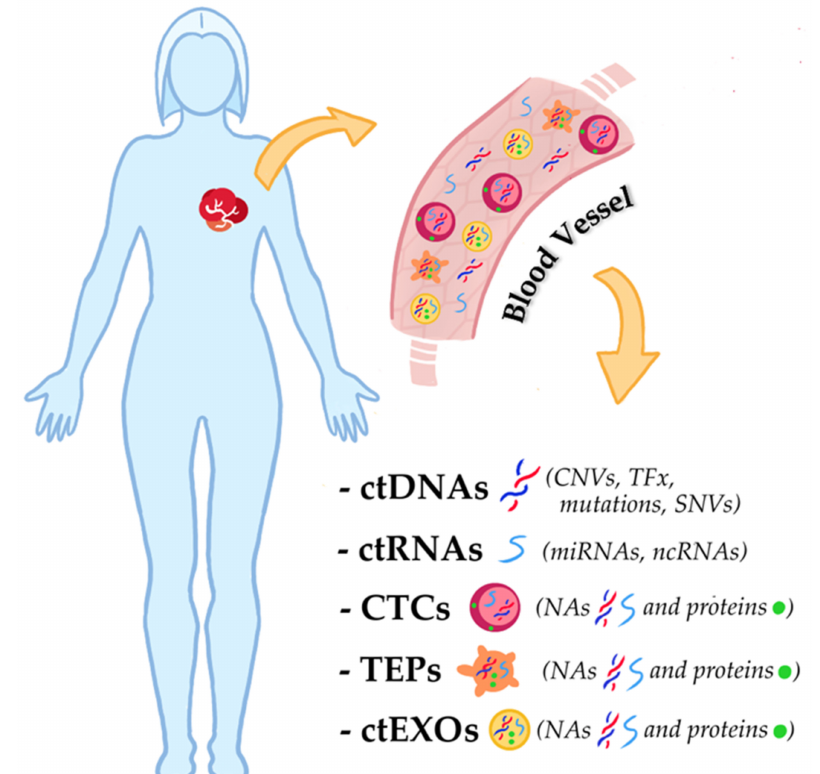
Figure 1. Scheme of principal targets from liquid biopsy in TNBC research. As shown in the figure, the biomolecular analysis from body fluids, such as blood, is not limited to circulating cell-free nucleic acids but also considers the tumor biomolecules carried by CTCs, TEPs, and ctEXOs. Abbreviations: CNVs (copy number variations); CTCs (circulating tumor cells); ctDNAs (circulating cell-free tumor DNAs); ctEXOs (circulating tumor exosomes); ctncRNAs (circulating cell-free tumor non-coding RNAs); NAs (nucleic acids); ncRNAs (non-coding RNAs); SNVs (single nucleotide variations); TEPs (tumor-educated platelets); TFx (tumor fraction of circulating cell-free